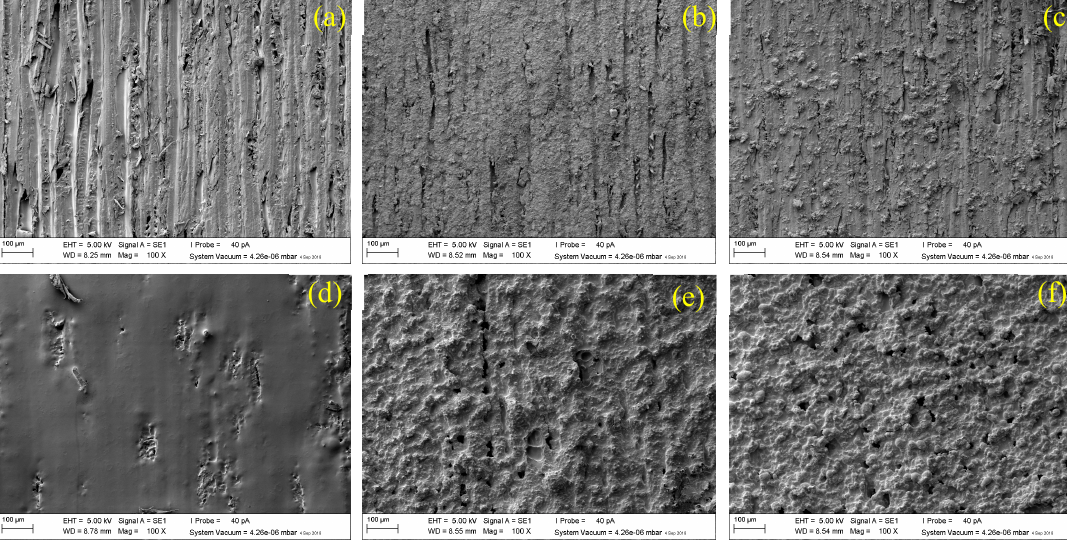
Figure 2. Scanning electron microscopy (SEM) images of pine wood ( a ) with different coatings: ( b ) Bi, ( c ) eCon, ( d ) polyester, ( e ) polyester and bismuth (PBi) and ( f ) polyester and eCon (PeCon).